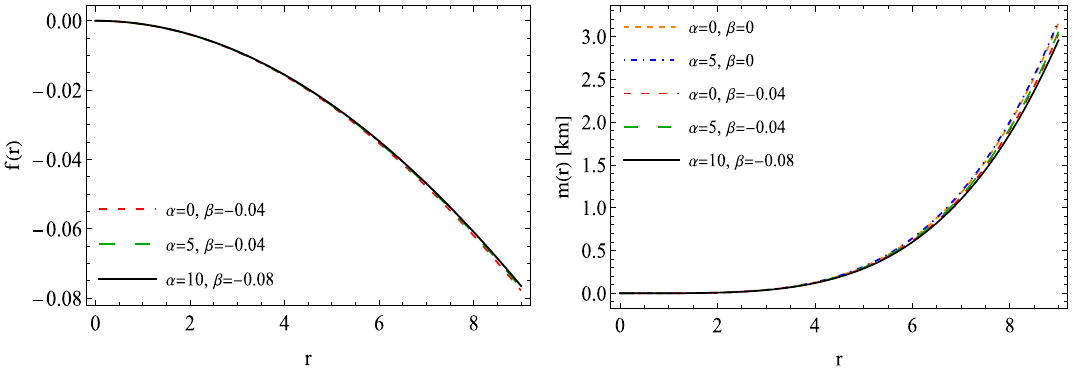
Fig. 3 The behavior of deformation function f ( r ) - left panel and mass function m ( r ) - right panel versus r for solution Sect.